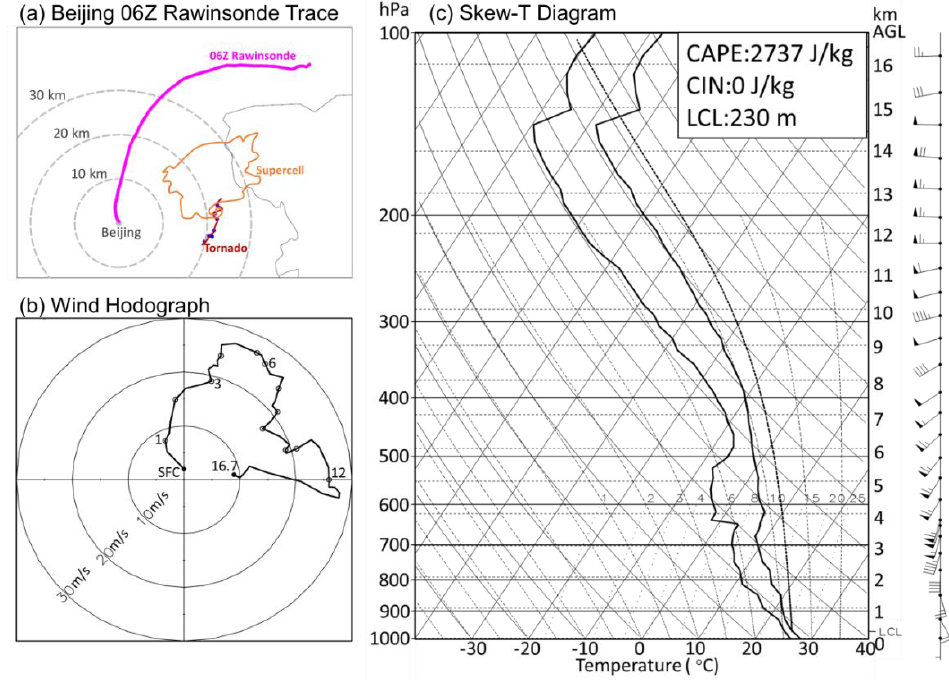
Figure 1. Beijing weather station rawinsonde in close proximity to the Beijing tornado at 0600 UTC (1400 LST, which was launched at 1315 LST) on 21 July 2012. ( a ) Spatial proximity of the rawinsonde trace (magenta curve) to the supercell (denoted by the contour of 45 dBZ at 2.4° elevation angle at 1350 LST) and the tornado track (in red, adapted from MY14). The blue dots show the seven a ff ected villages. The grey curve is the eastern border of Beijing. The Beijing weather station is denoted by the grey dot and the distance scale is given by concentric grey dashed circles. ( b ) Hodograph of the Beijing rawinsonde, with the altitudes (km) of di ff erent levels given alongside the curve. ( c ) Vertical profiles of temperature, dew point and wind from the rawinsonde in a Skew-T diagram. Also shown are the values of CAPE, CIN and